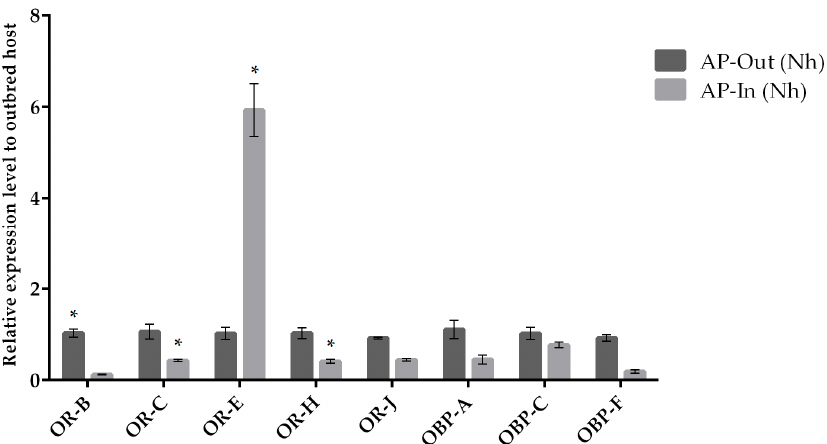
Figure 5. Mean (+/ − SE) expression levels of ORs and OBPs from the heads of outbred (AP-exogamic) and inbred (AP-endogamic) A. ervi maintained on their natal host A. pisum (AP), measured by RT- qPCR. RT-qPCRs were performed using specific primers for each gene. Normalizer gene: RPL19. The asterisk * above the bars indicates significant differences according to two-way ANOVA ( p value < 0.05).